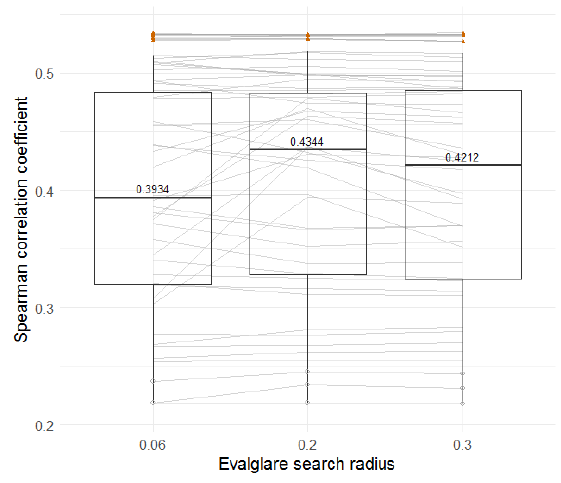
Figure 19. Boxplots of Spearman rho for the three search radius (laboratory study). Buildings 2018 , 8 , x FOR PEER REVIEW